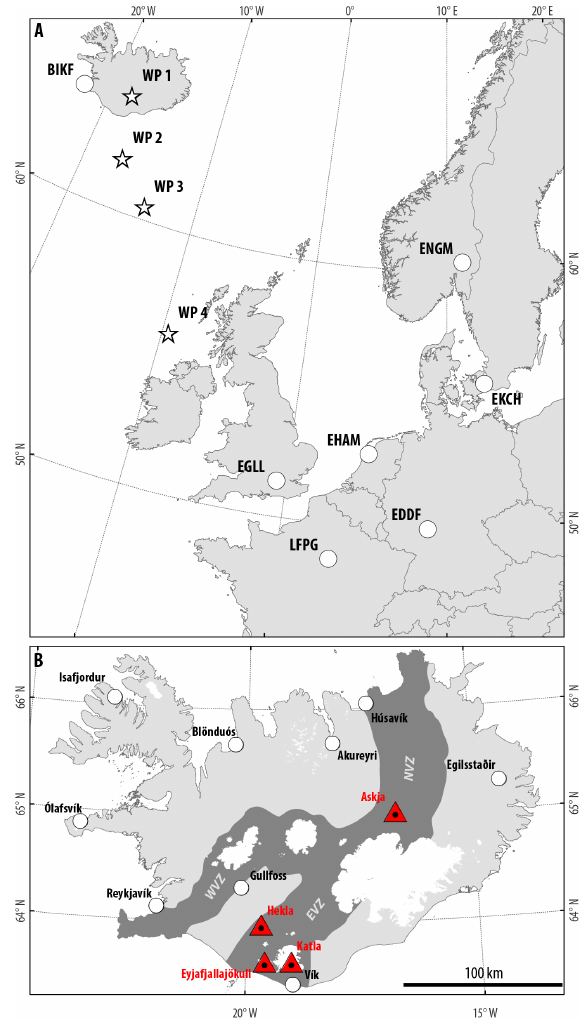
Figure 1. Overview of the computational domains at (a) large and (b) small scales: (a) shows the locations of wind profiles (stars) used in Fig. 3 and the main airports (circles) of London Heathrow (EGLL), Paris Charles de Gaulle (LFPG), Amsterdam Schiphol (EHAM), Frankfurt (EDDF), Oslo Gardermoen (ENGM), Copen- hagen Kastrup (EKCH) and Keflavik (BIKF); (b) shows the target volcanoes (red triangles) and the relevant volcanic zones for this study (WVZ: Western Volcanic Zone; EVZ: Eastern Volcanic Zone; NVZ: Northern Volcanic